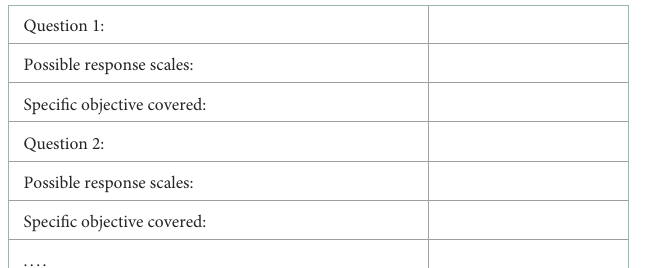
TABLE 5 Final questionnaire.